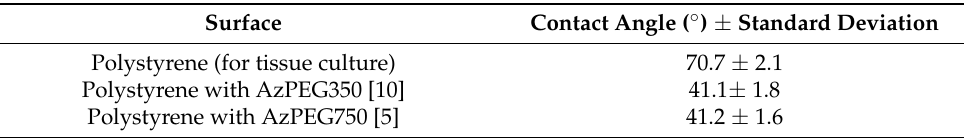
Table 2. Contact angles on different surfaces.